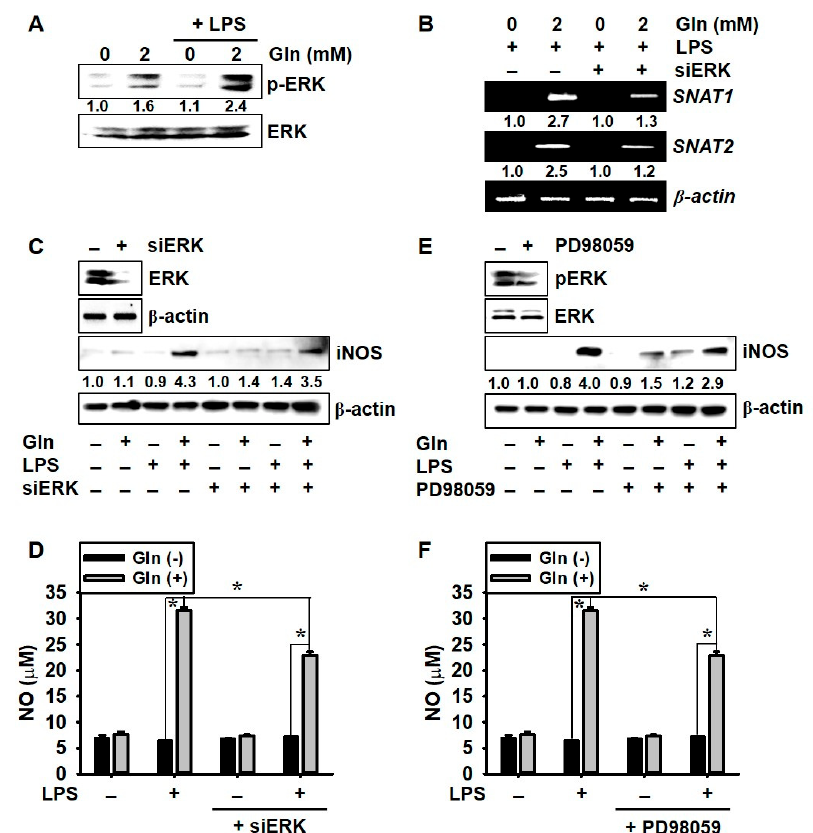
Figure 5. Glutamine (Gln) promotes extracellular signal-regulated kinase (ERK) phosphorylation and nitric oxide (NO) production as well as the expression of sodium-coupled amino acid transporter 1 ( SNAT1 ) and SNAT2 , under lipopolysaccharide (LPS) stimulation. BV2 microglial cells were incubated with 2.0 mM Gln, 2 h before treatment with 500 ng / mL LPS. ( A ) After 24-h incubation with LPS, protein lysates were resolved on the SDS-polyacrylamide gels, transferred to nitrocellulose membranes, and probed with specific antibodies against p-ERK and ERK. Total ERK was used as an internal control. Densitometry values were expressed, as compared to the total ERK levels; displayed at the bottom of the figure. ( B ) Total mRNA was isolated at 6 h and RT–PCR for SNAT1 and SNAT2 was performed. β -Actin was used as an internal control for RT–PCR. Densitometry values were expressed compared to the β -actin levels; displayed at the bottom of the figure. ( C , D ) The cells were transiently transfected with ERK -targeting siRNA (siERK) for 48 h. ( C ) Western blotting was performed to check ERK phosphorylation (top) and iNOS expression (bottom). ( D ) NO production was measured by the Griess reagent assay. ( E , F ) The cells were also preincubated with an ERK inhibitor, PD98059 (20 µ M), for 2 h and were treated with LPS for 24 h. ( E ) Western blotting was performed to check ERK phosphorylation (top) and iNOS expression (bottom). ( F ) NO production was measured by Griess reaction. β -Actin was used as an internal control for iNOS protein expression. Densitometry values were expressed as compared to the β -actin levels; displayed at the bottom of the figure. The results are the average of three independent experiments and are expressed as the mean ± standard error of the median (* p <